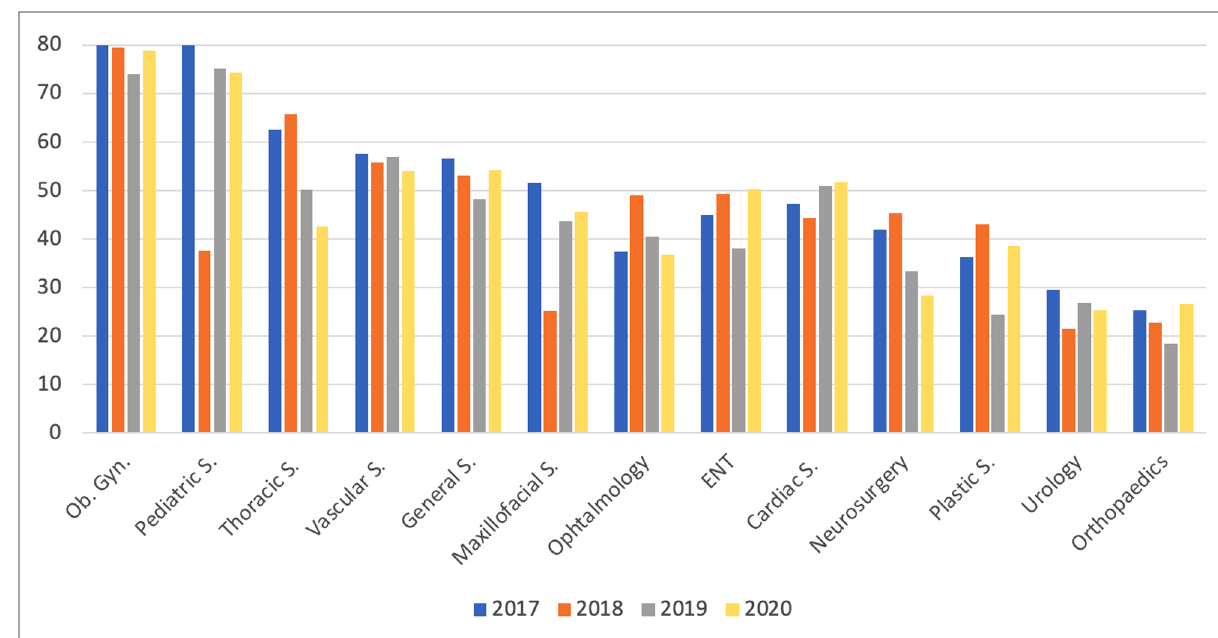
FIGURE 3 Percentage of candidates matriculating into a surgical residency program that were female, in the 2017 – 2020